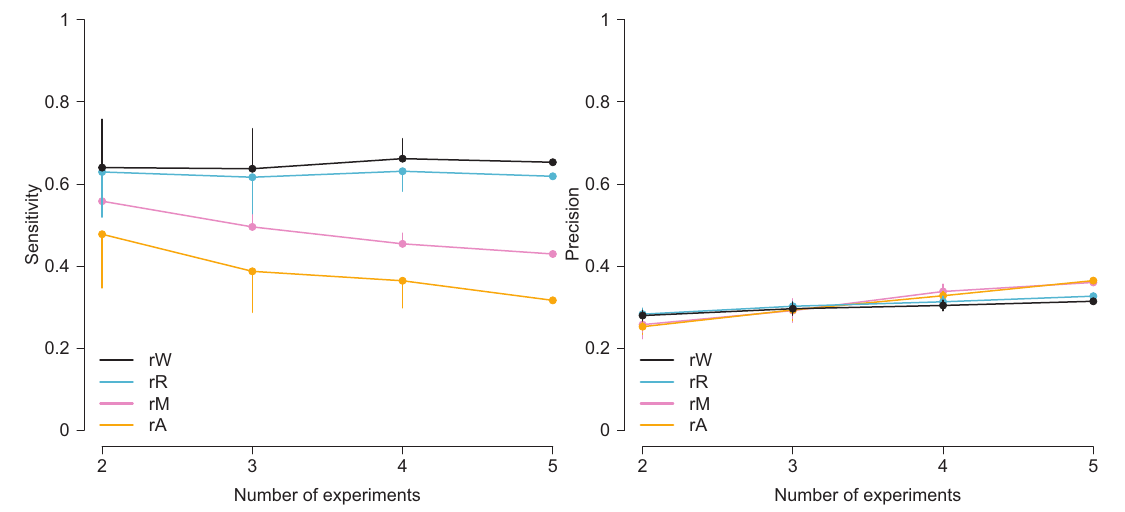
Figure 2: Sensitivity and precision as a function of the number of experiments. The meta- correlations over short-profile experiments were compared to the meta-correlations identified in the meta-analysis of the two largest experiments E2 and E4. The graphs show the average sensi- tivity (left graph) and the average precision (right graph) over several meta-analyses of 2-5 short- profile experiments at the absolute correlation cutoff of 0.6. The error bars represent the standard